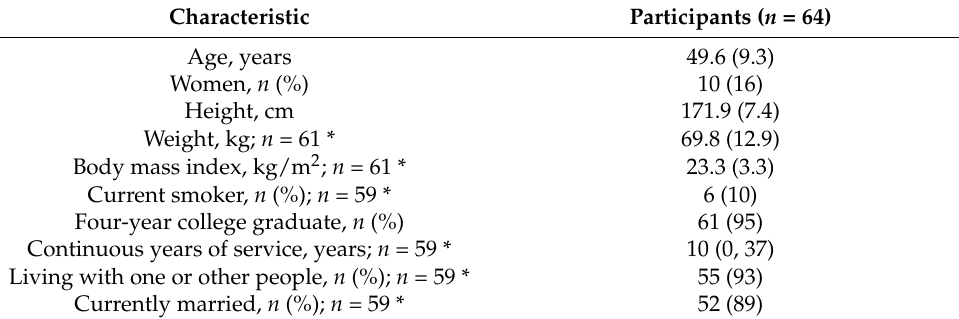
Table 1. Characteristics of participants at